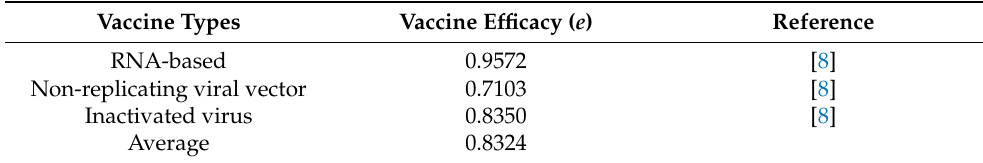
Table 1. The vaccine efficacy depends on the type of